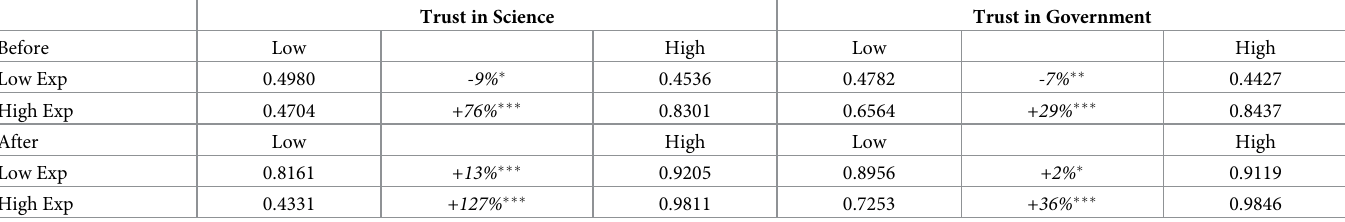
Table 4. Self-reported compliance and